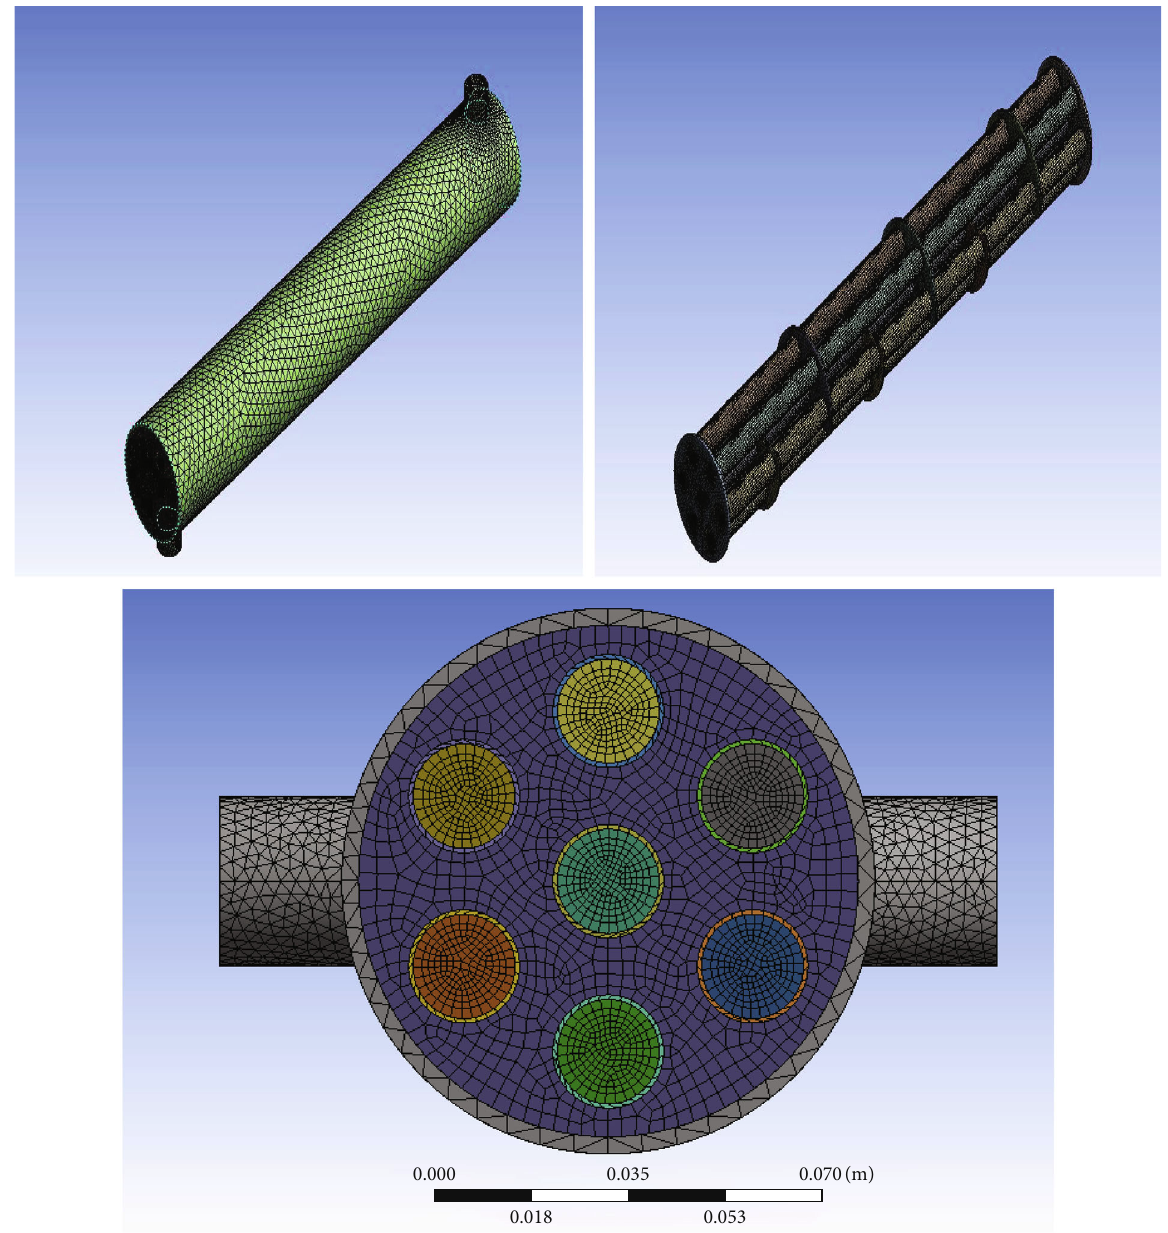
Figure 2: Meshed